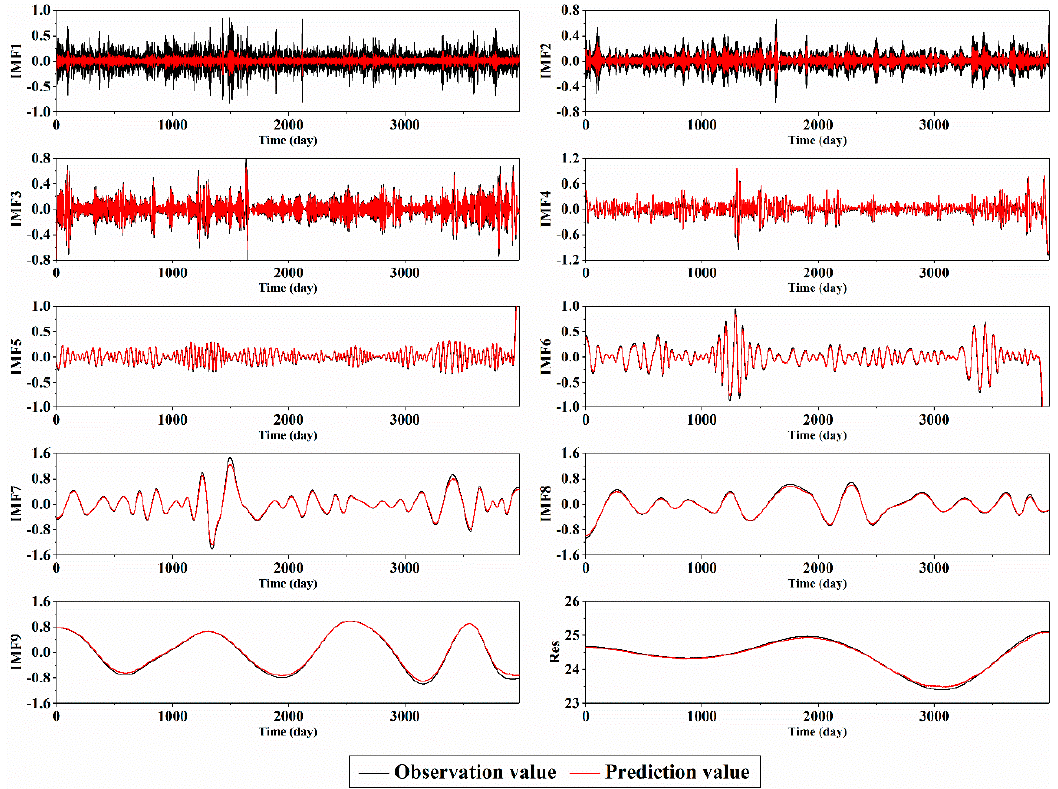
Figure 5. The predicted results of the EMD decomposition signal.